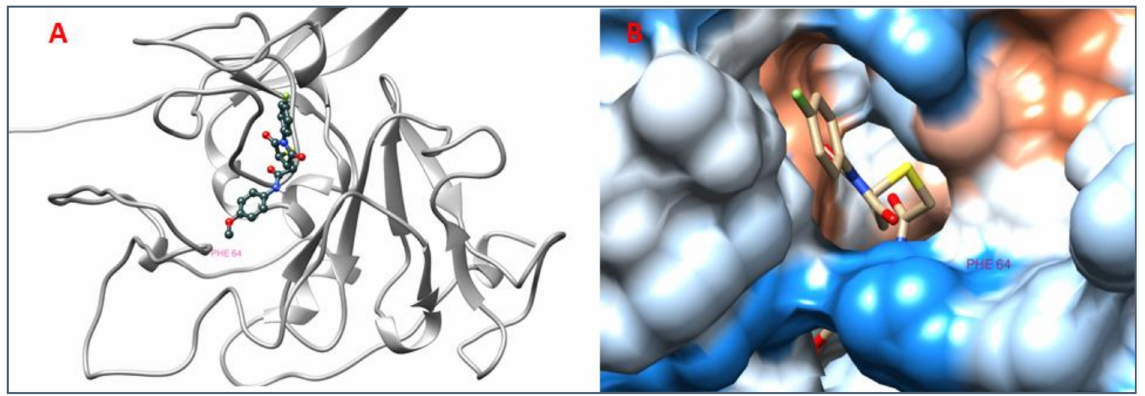
Figure 9. ( A ) 3D interaction of ethyl N-[2,4,6-trioxo-1-(2-phenylethyl)-5-(trifluoromethyl)-7H-pyrrolo[2,3-d]pyrimidin-5-